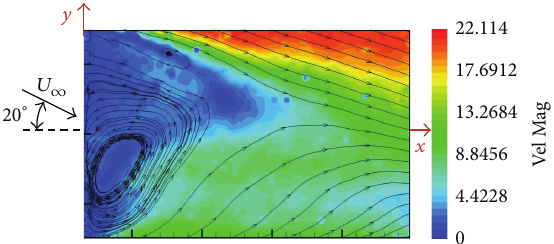
Figure 9: Velocity map in the horizontal plane of the SFS flight deck at 20 ∘ of angle of incidence ( 𝑧/𝐻 = 0.5